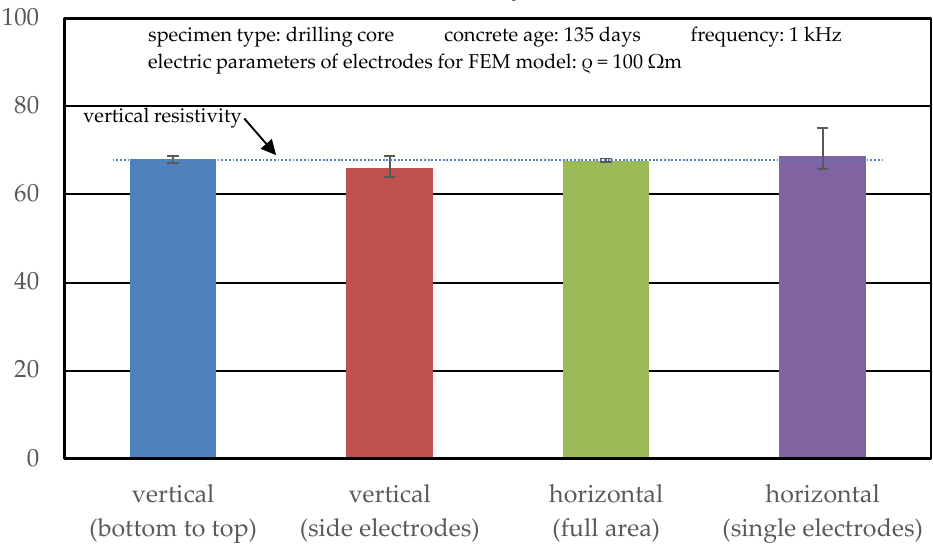
Figure 11. Calculated electrical resistivity of PC drilling cores in different electrode configurations, simulated with the resistivity of concrete.